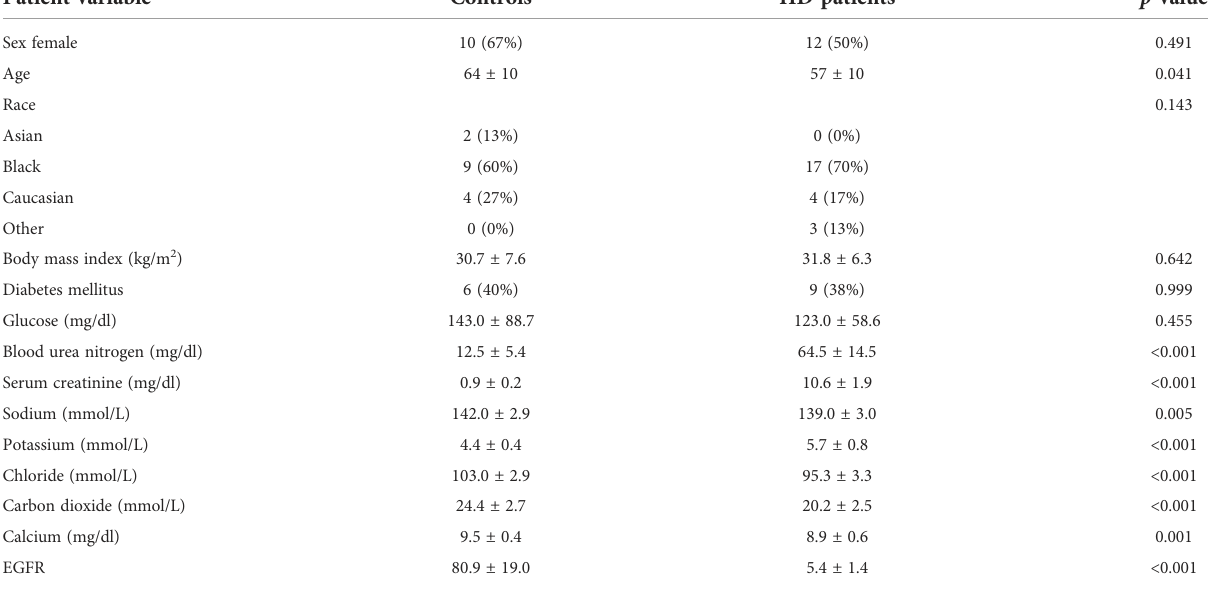
TABLE 1 Subject